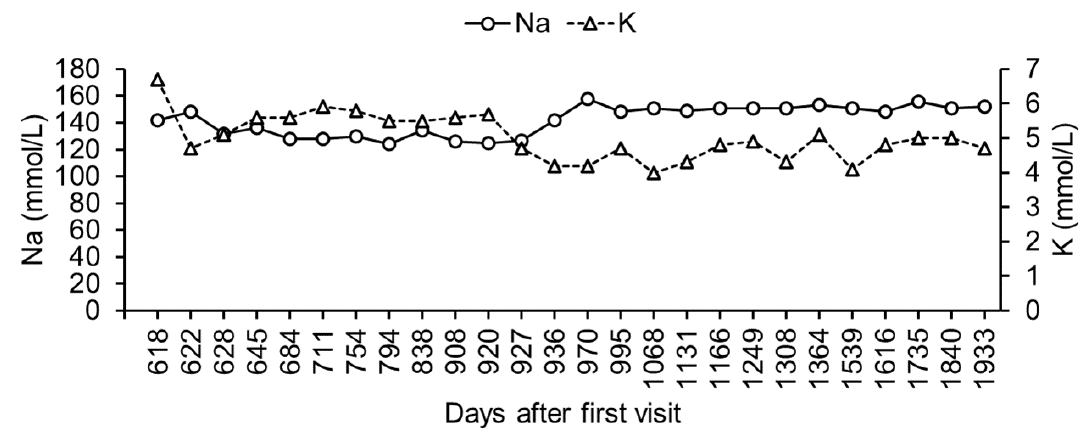
Figure 3. Changes in blood sodium and potassium level. Blood sodium and potassium were measured at least once every 10 days. Only the representative values are shown.